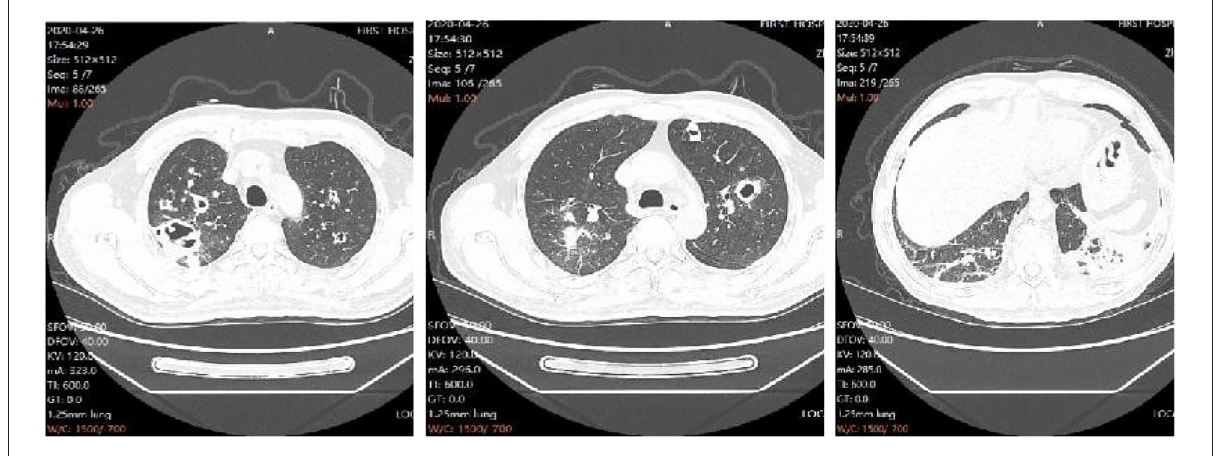
FIGURE1 Radiographic progression of